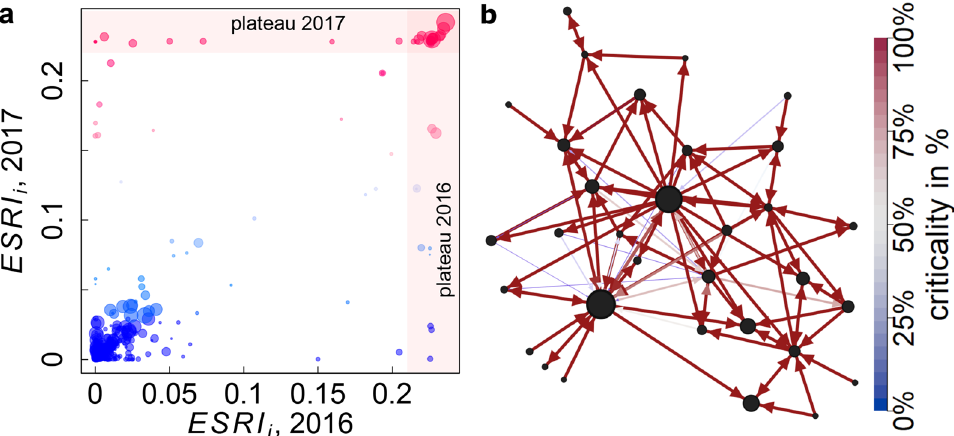
Figure 4. More details on ESRI. ( a ) Systemic risk in 2016 vs. 2017. Colors correspond to ESRI in 2017. Blue and red symbols indicate low and high values in 2017, respectively. Note the strong variability in the plateau firms. There is a significant correlation between ESRI in 2017 and 2016, that indicates relatively small temporal fluctuations for the bulk of the companies. ( b ) Network of the 32 most systemically risky firms (plateau) in 2017. Node size is proportional to the square root of strength. Link colors correspond to the downstream ’criticality’, i.e., the percentage of j ’s production should i stop functioning, (cid:31) d ij . Red thick (blue, thin) links indicate very large (small) losses of production. Small companies predominately supply to large high-risk companies, thereby inheriting systemic risk.